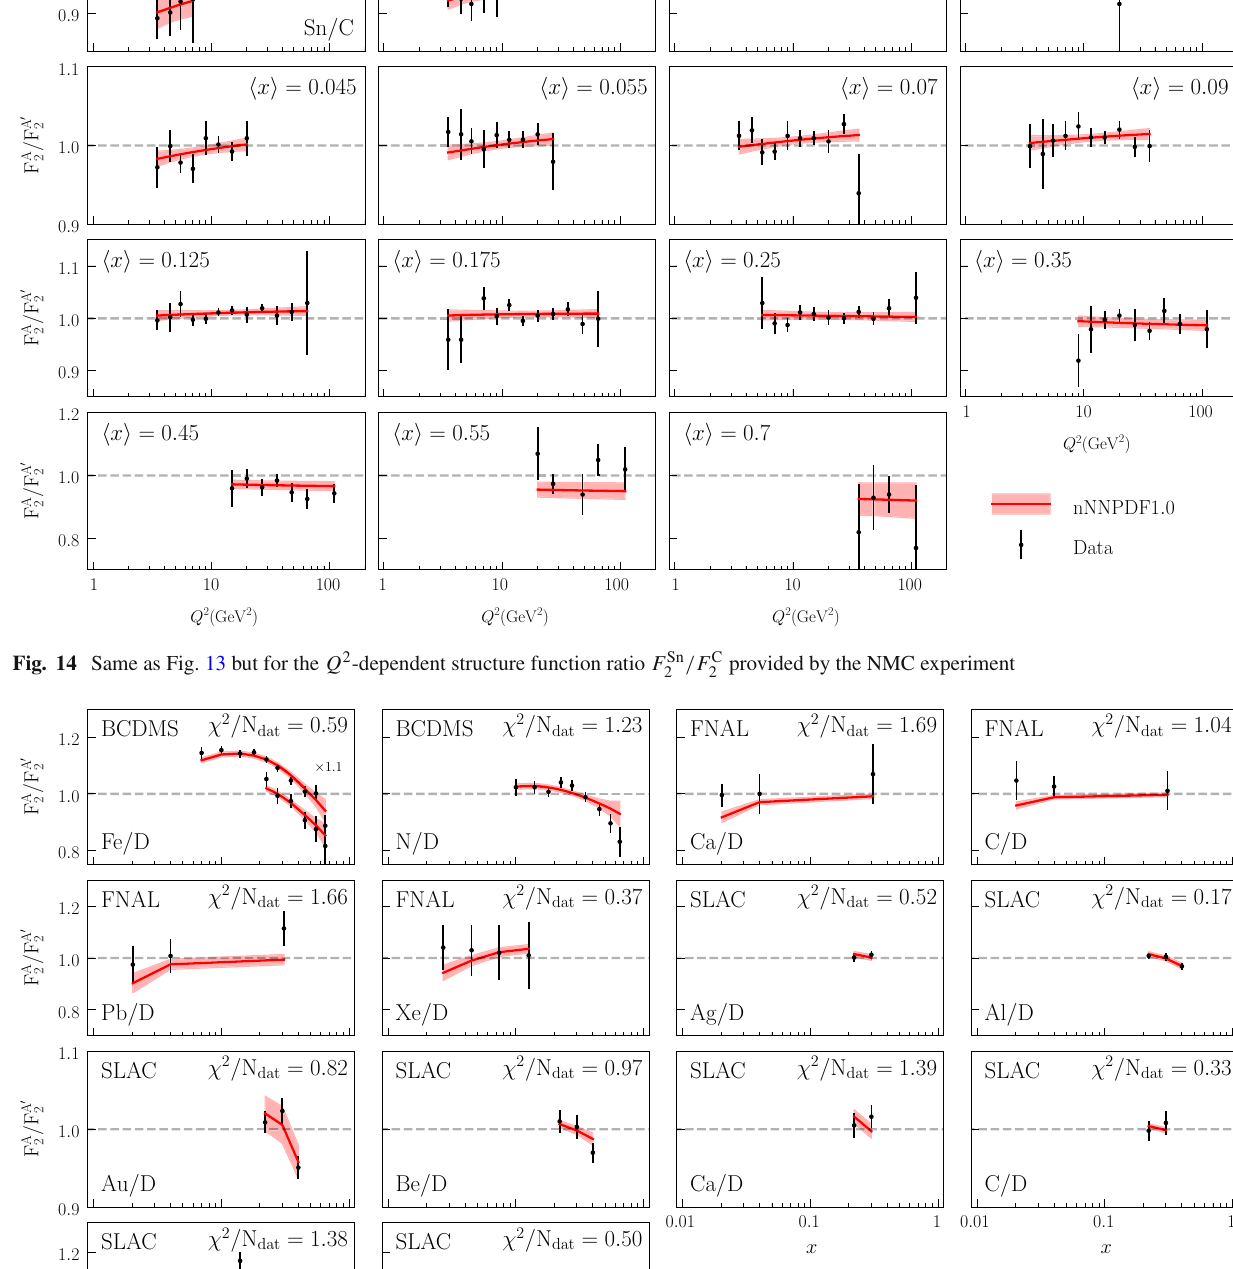
Fig. 15 Same as Fig. 13 but for the data provided by the BCDMS, FNAL E665, and SLAC-E139